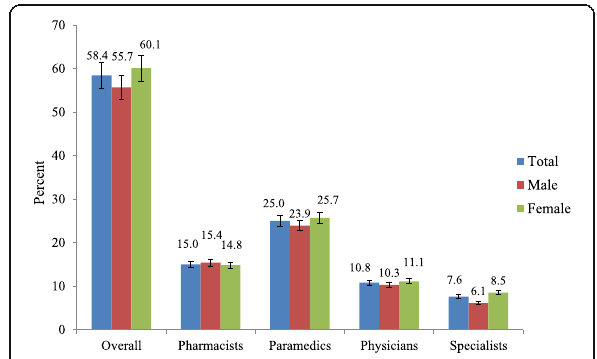
Fig. 1 Medical consultation according to class of professional health-care provider, by gender (proportions, with 95% confidence